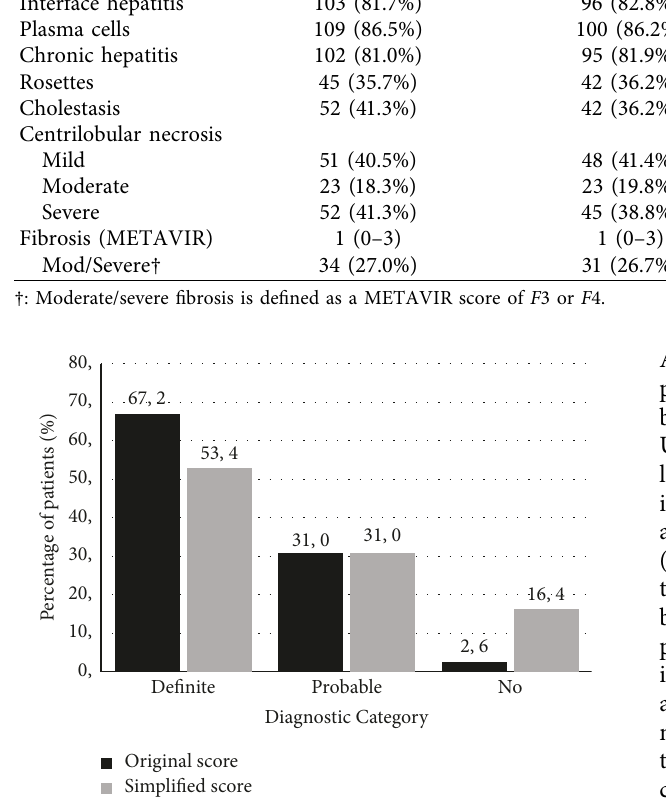
Figure 1: Performance of the original and simplified scores in identifying 117 patients in the